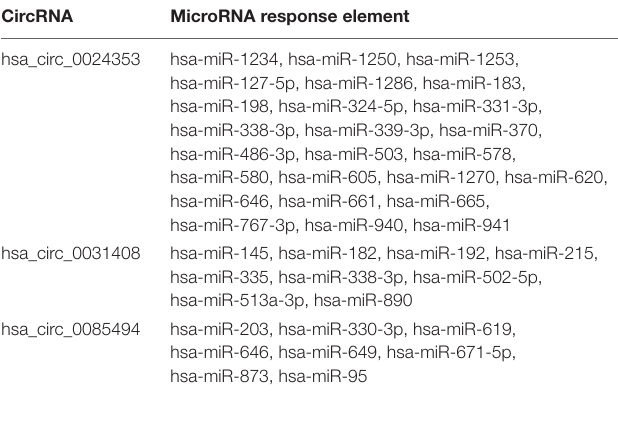
TABLE 2 | Predicted miRNA response elements of